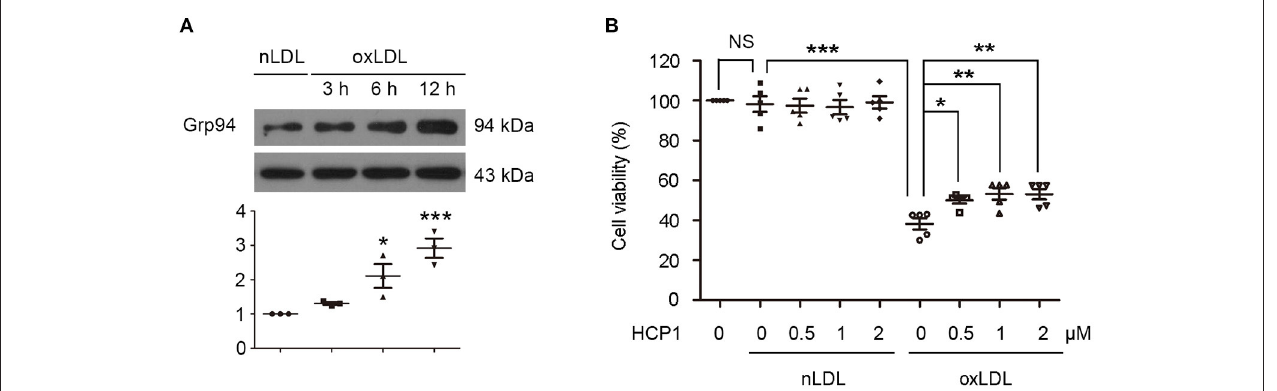
FIGURE 1 | OxLDL upregulated Grp94 level and HCP1 inhibited oxLDL-induced viability reduction in HUVECs. (A) Protein levels of Grp94 were detected after treatment with nLDL (50 µ g/ml) or oxLDL (50 µ g/ml) for the indicated time in HUVECs. Data are mean ± SEM; * p < 0.05, *** p < 0.001; n = 3. (B) Viability of HUVECs treated with nLDL (50 µ g/ml) or oxLDL (50 µ g/ml) with or without HCP1 (0.5, 1, 2 µ M) for 48h. Data are mean ± SEM; * p < 0.05, ** p < 0.01, *** p < 0.001, NS p > 0.05; n = 5. Statistical analyses were performed using one-way